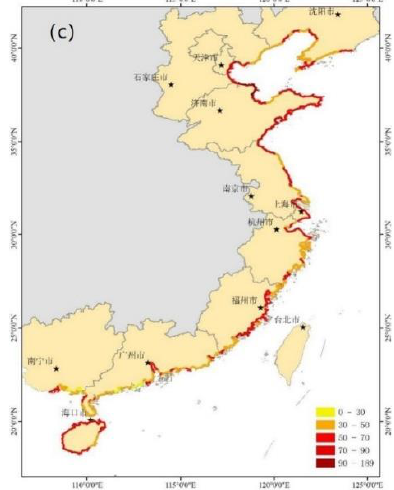
Figure 5 . Landscape importance degree variation rate of coastal zone at the county scale from 2015 to 2019.